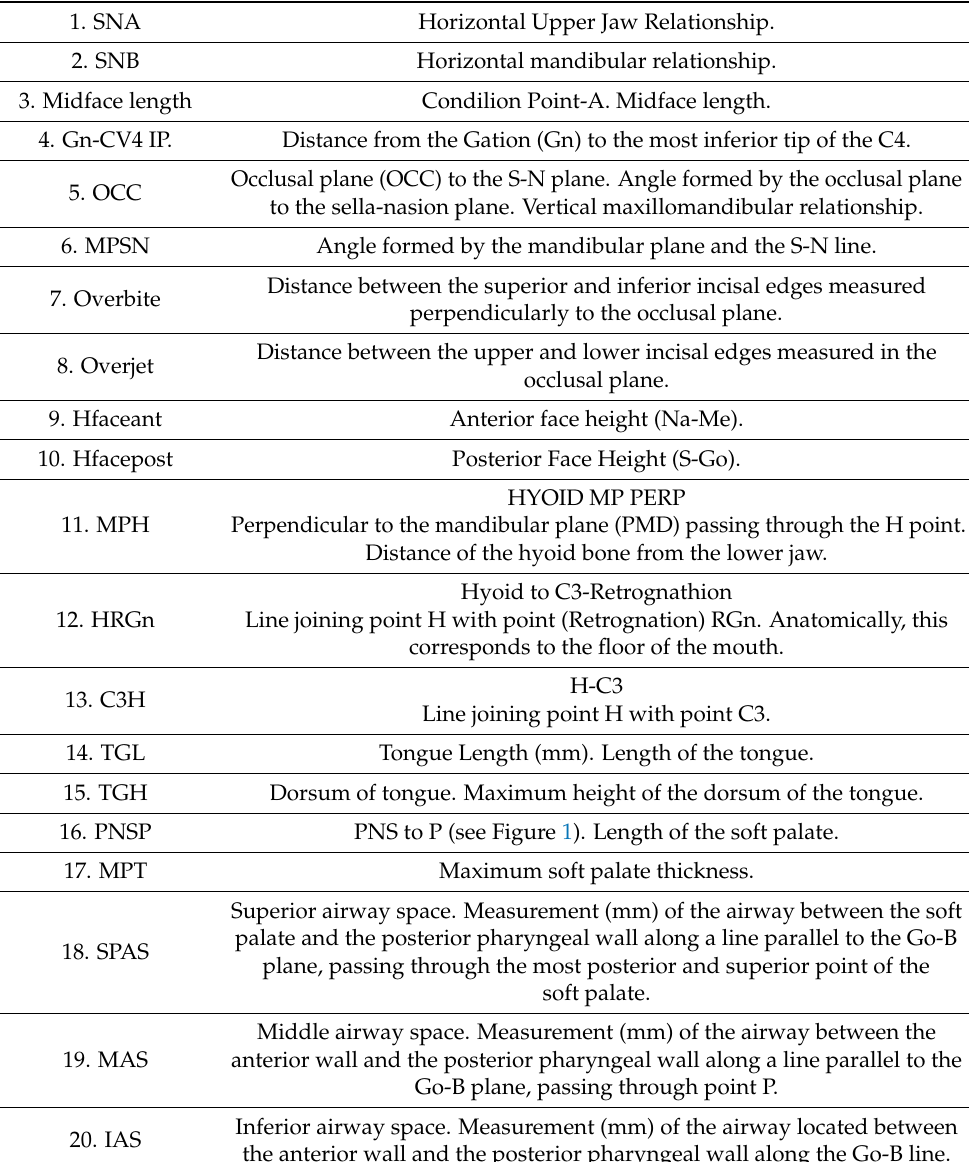
Table 1. Cephalometric variables and their